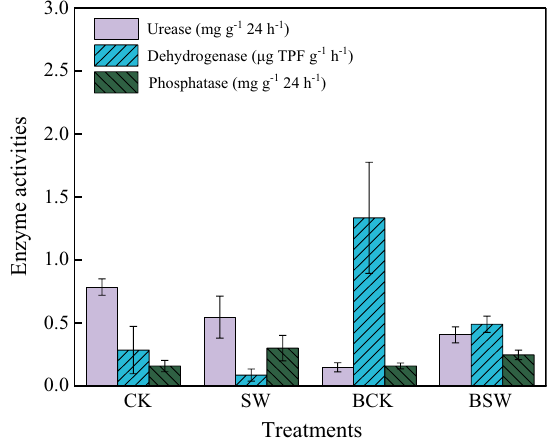
Fig. 3 Soil enzyme activities in soils under different treatments. CK: control; SW: soil treated with 1%‑biochar; BCK: soil treated with S. pasteurii ; BSW: soil treated with S. pasteurii and 1%‑biochar. Error bars represent the standard deviation of the means